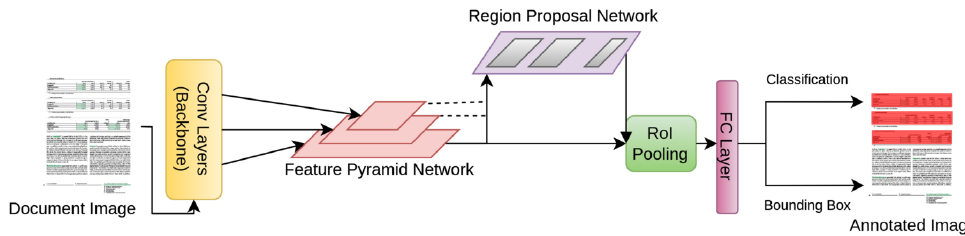
Figure 4. The detection pipeline for the Faster R-CNN detection head. Faster R-CNN builds upon Fast R-CNN by replacing the slow selective search with a small RPN, which reduces the time and cost of generating object proposals.